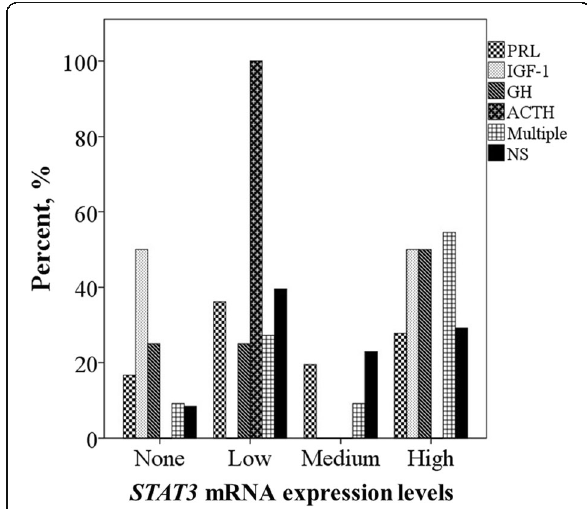
Fig. 4 PA hormone distribution in STAT3 mRNA expression levels. Fig. 5 STAT3 mRNA expression changes in invasive and non-invasive PRL secreting and non-secreting PAs. The horizontal bars represent the mean values with 95% confidence interval, the spots represent the amount of samples. PRL – prolactin, NS – non-secreting